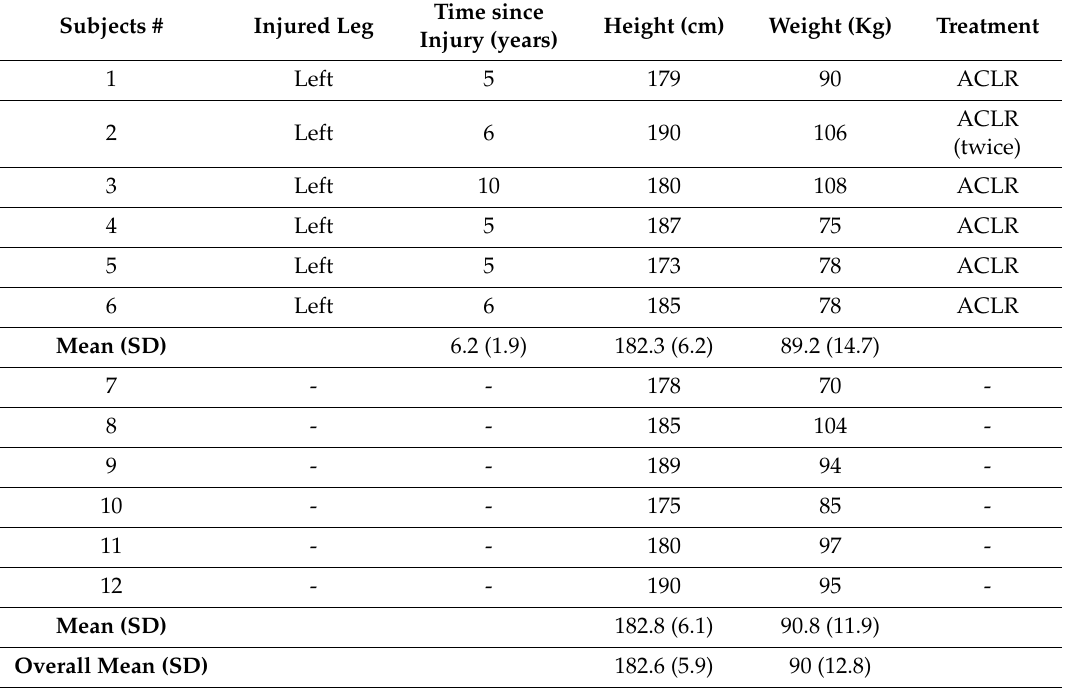
Table 1. Participants